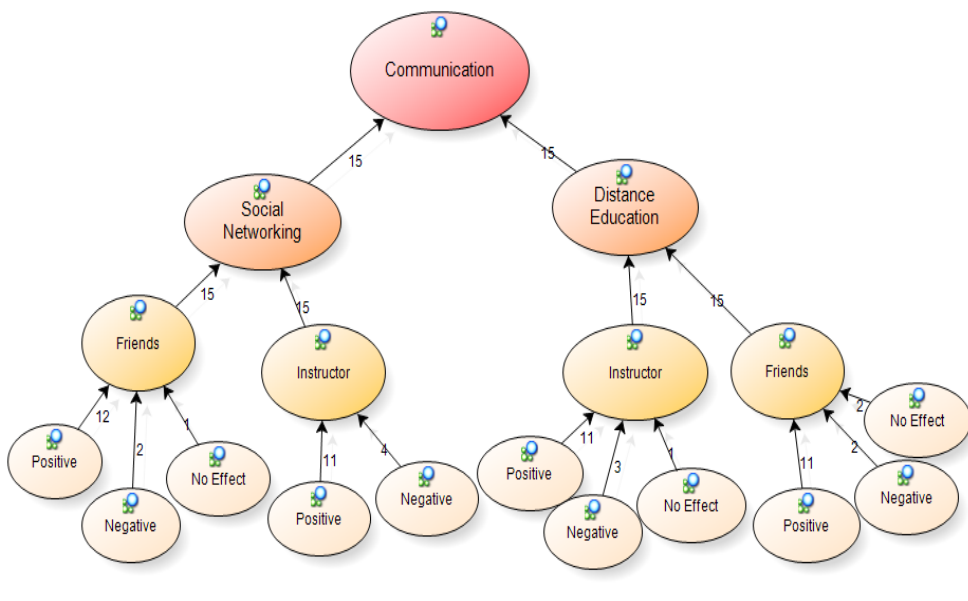
Figure 5. Model related to communication in the application